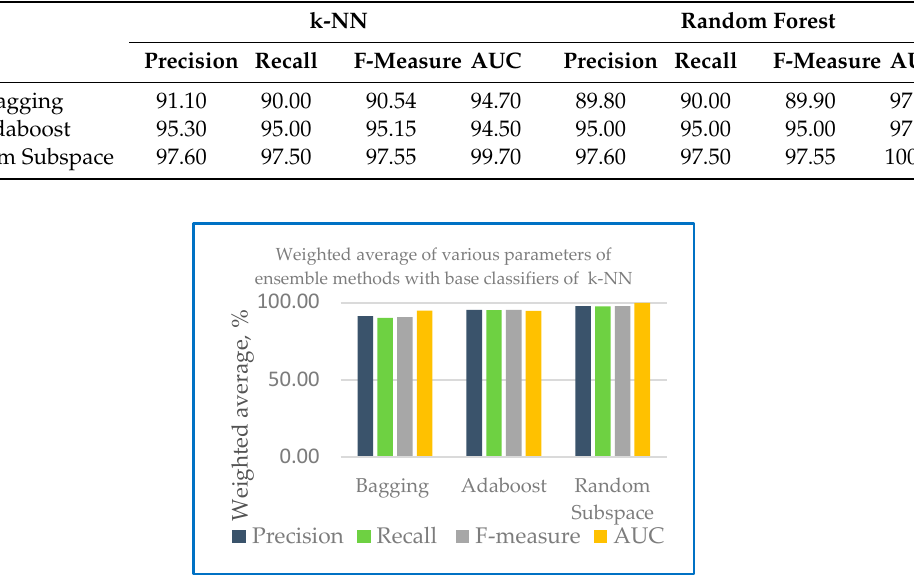
Figure 4. Weighted average of various parameters of ensemble methods with base classifiers of k-NN .